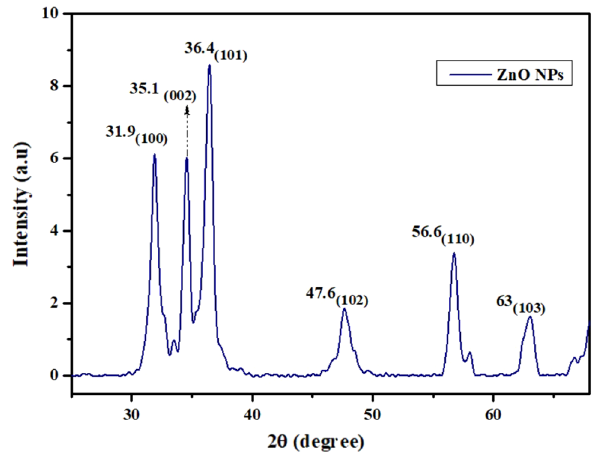
Figure 5. X-ray Diffraction analysis of Nigella sativa mediated ZnONPs.